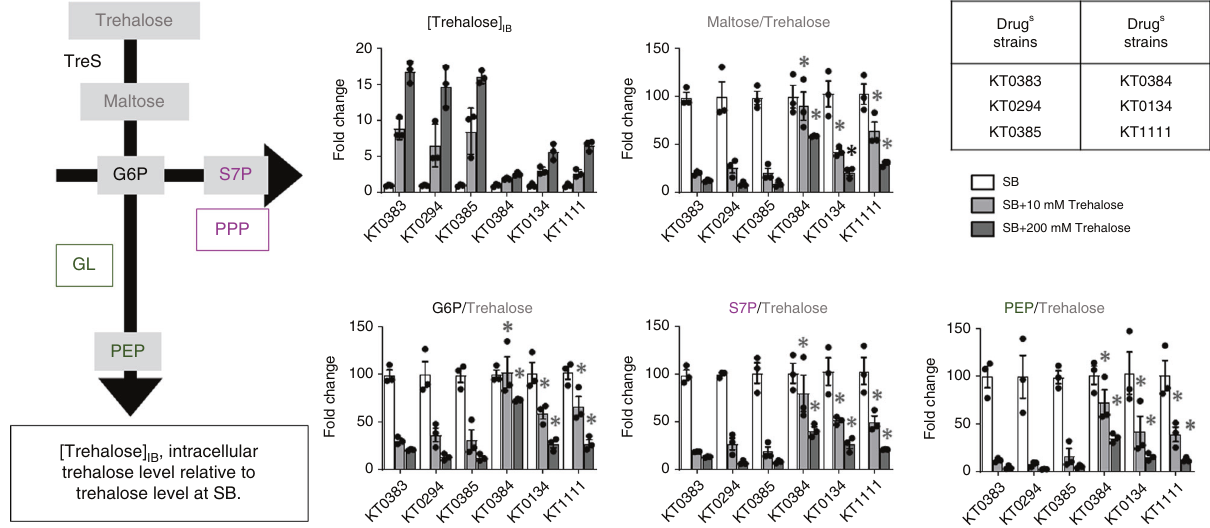
Fig. 7 The effect of supplementing trehalose on TB clinical isolate metabolism. Supplementation with 10 or 20 mM trehalose on the central metabolic pathways of drug-sensitive, Drug S , (KT0294, KT0383, and KT0385), and drug-resistant, Drug R , XDR- (KT0134 and KT0384), and TDR- (KT1111) TB clinical isolates was monitored by metabolomics. Left panel, trehalose metabolism, glycolysis (GL), and the pentose phosphate pathway (PPP) intermediates were analyzed. Right panel, [Trehalose] IB showed intrabacterial trehalose detected within each TB clinical isolate strain following exposure to 0, 10, or 20 mM trehalose supplementation for 24h. Metabolite fold change describes the percent conversion rate using intake trehalose under each condition, including 0, 10, and 20 mM trehalose supplementation. The conversion rate of each metabolite from trehalose under SB (sodium butyrate with 0 mM trehalose) was set to 100%. All values are the average of biological triplicates ±s.e.m. * P < 0.01 by Student ’ s unpaired t-test (between drug-resistant TB isolate metabolites and the average of the corresponding metabolite of drug-sensitive TB isolates; KT0294, KT0384, and KT0385). Data shown represent the combined results of duplicates of three replicates. Source data are provided as a Source Data fi